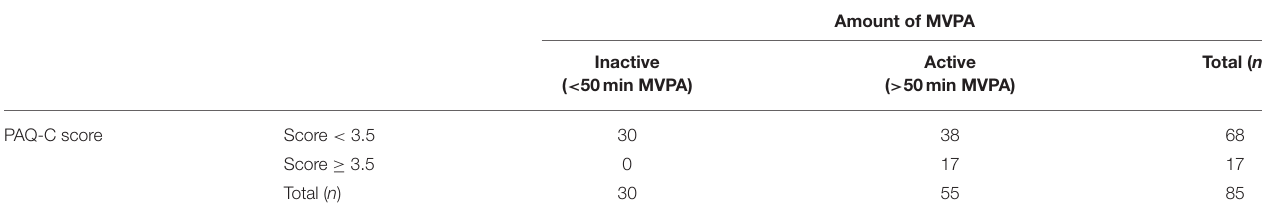
TABLE 3B | Classification matrix of the PAQ-C threshold of 3.5 to distinguish the amount of children ( n ) above or below a MVPA level of